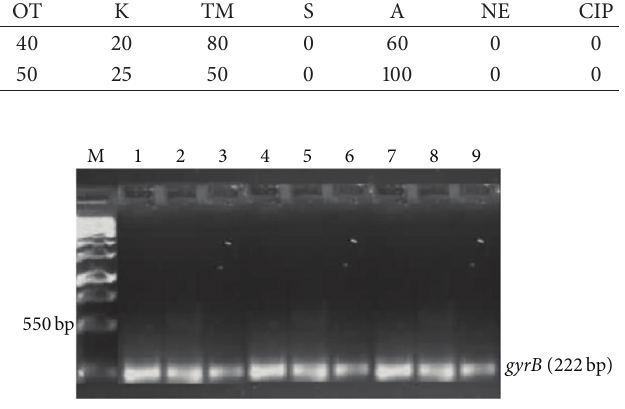
Figure 2: Image of a composite agarose (1% w/v) gel depicting DNA extracted from Pseudomonas species. Lane M (1kb DNA Ladder); Lane 1–9 ( gyrB gene fragments (222 bp) from Pseudomonas species isolated from different sites.